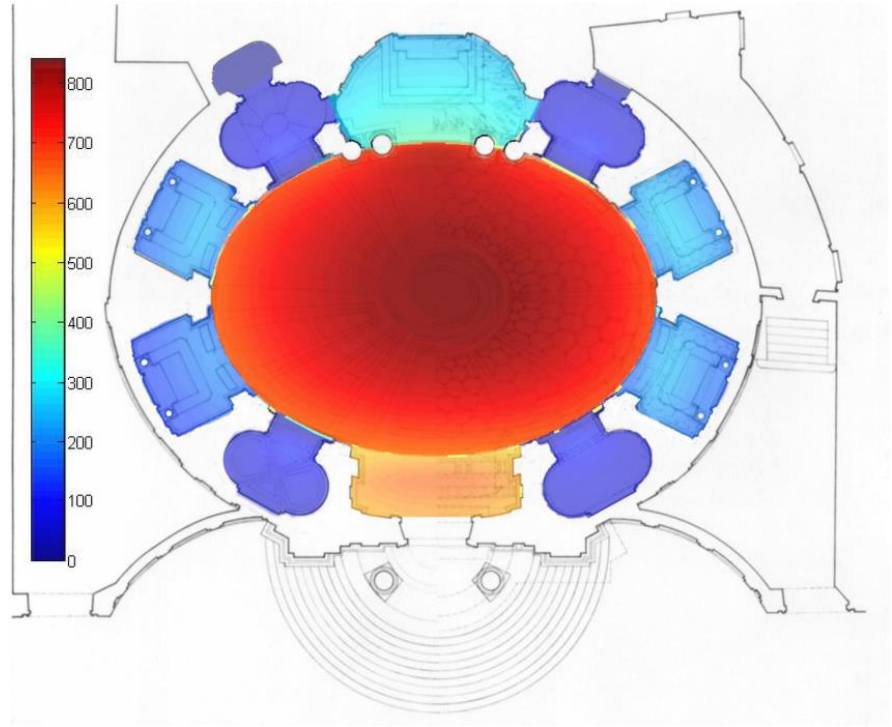
Figure 11. Distribution of light in the plan, showing the contrast between the central space and the chapels.